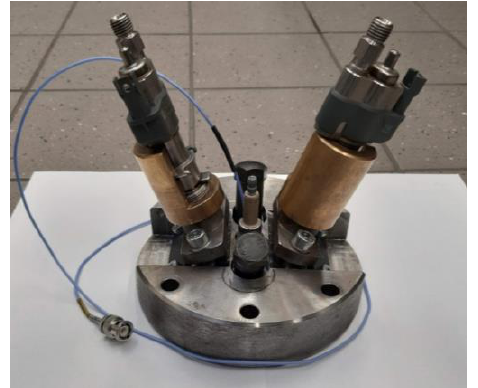
Fig. 8. The RCM head adjusted for the dual-fuel injection system Fuel was supplied by two high-pressure injection pumps from the BMW M4 GTS. The original system was modified by disconnecting the cable connecting the two pumps, which made it possible to supply the system with two dif- ferent fuels independently (Fig. 9). The system enables independent fuel pressure adjustment in the range of 5–30 MPa.